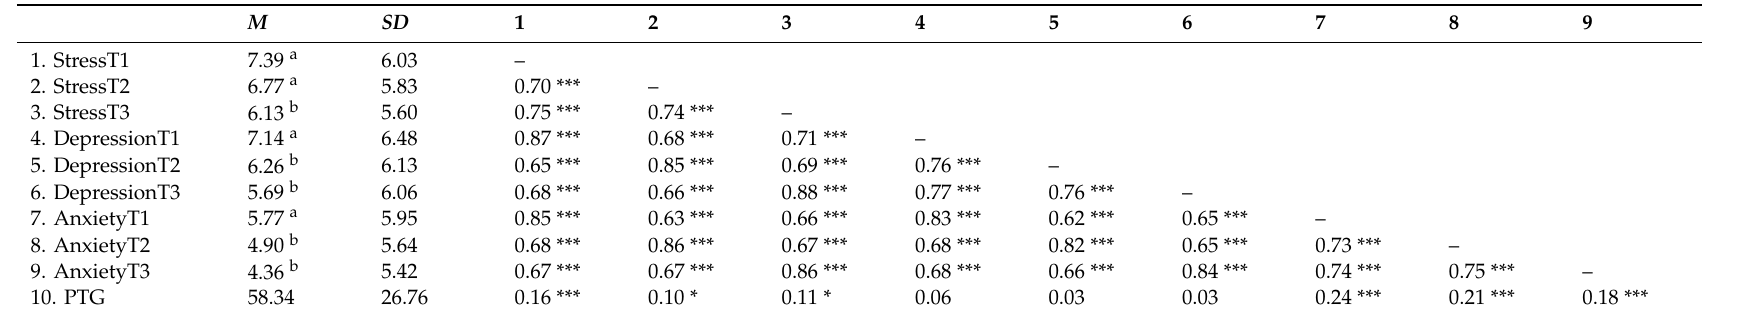
Table 3. Means, Standard Deviations, and Bivariate Correlations of Mental Health Outcomes.